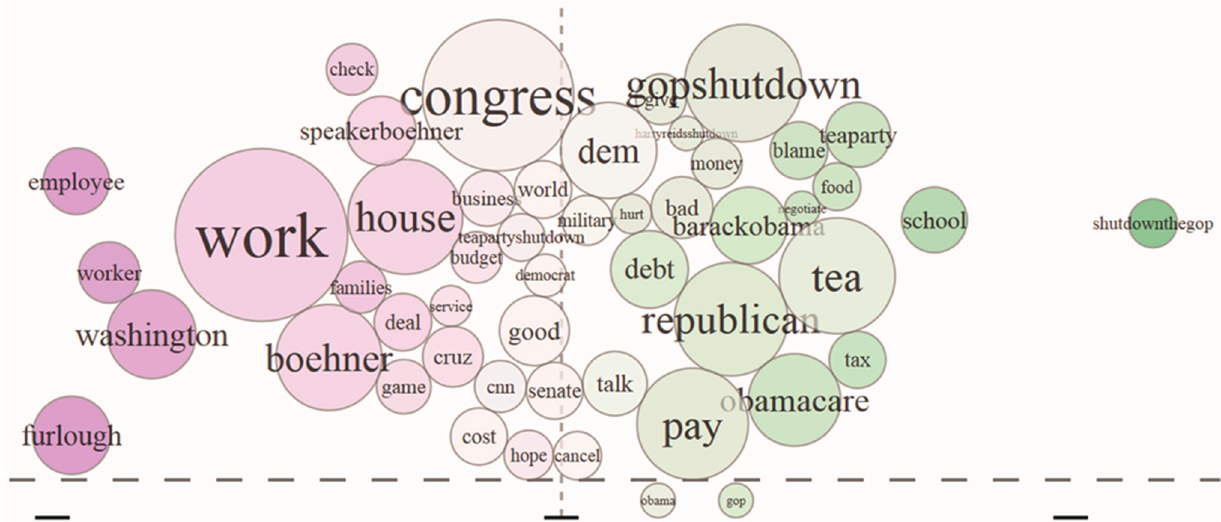
Figure 8. A detailed view of the term polarity plot comparing Maryland ( left ) with New Jersey ( right ) exposes the concerns of the federal workforce in